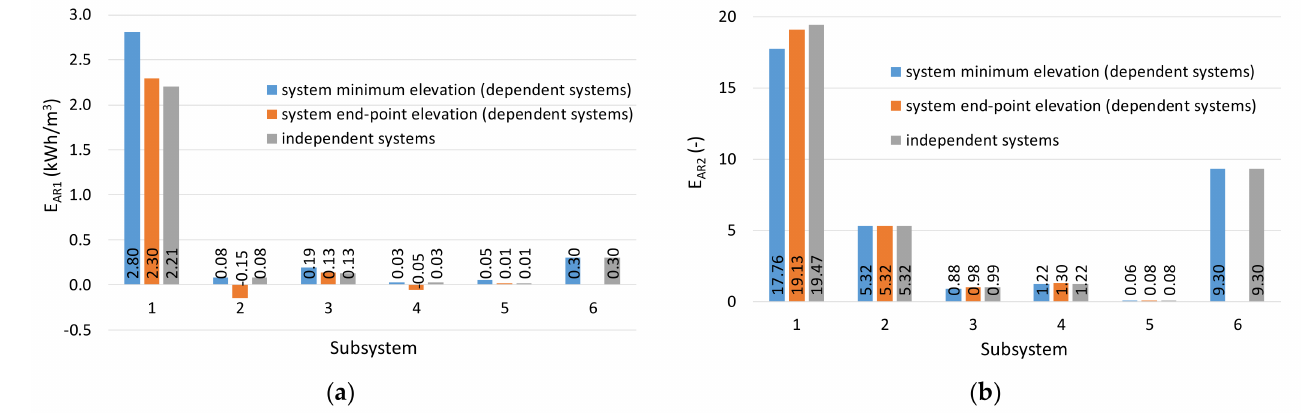
Figure 4. Performance indices to analyse the system reference elevation: ( a ) E AR